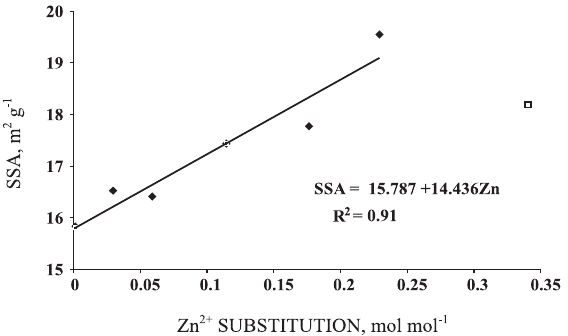
Figure 7. Specific surface area (SSA) of synthetic maghemites with different zinc isomorphic substitution degrees. ( ) Outlier, not considered in